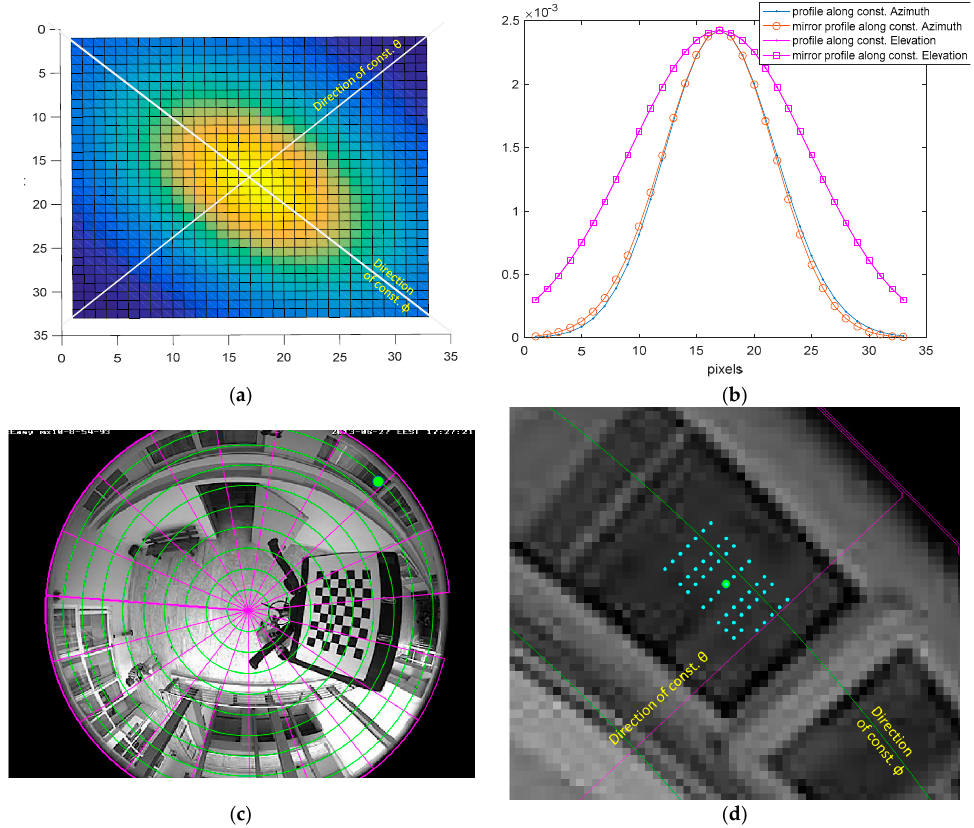
Figure 6. ( a ): The shape of the geodetic Gaussian kernel, generated at the location of the frame indicated by a green circle ( c ). Contours of iso-azimuth and iso-elevation are also superimposed. The shape and symmetry of the kernel is demonstrated in ( b ), along the direction of constant (iso-) azimuth and constant (iso-) elevation. Finally, image resampling to construct the geodetic neighborhood, according to [22] is shown in ( d ) .